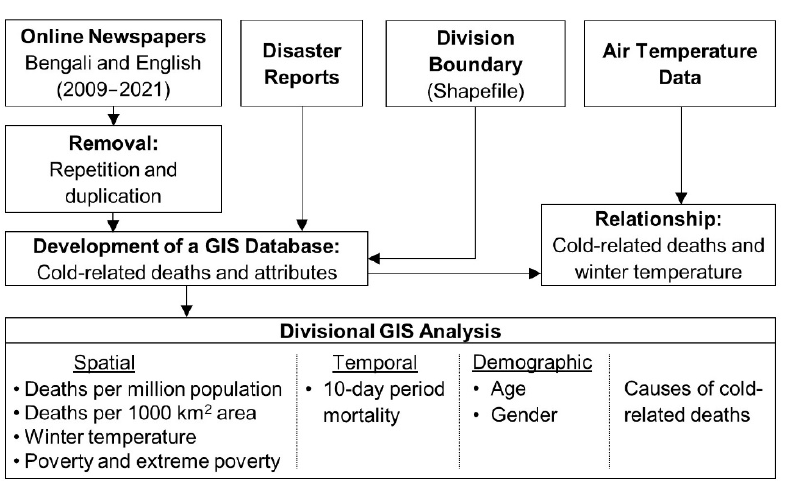
Figure 2. A schematic diagram of the GIS database development and the methodology followed in this